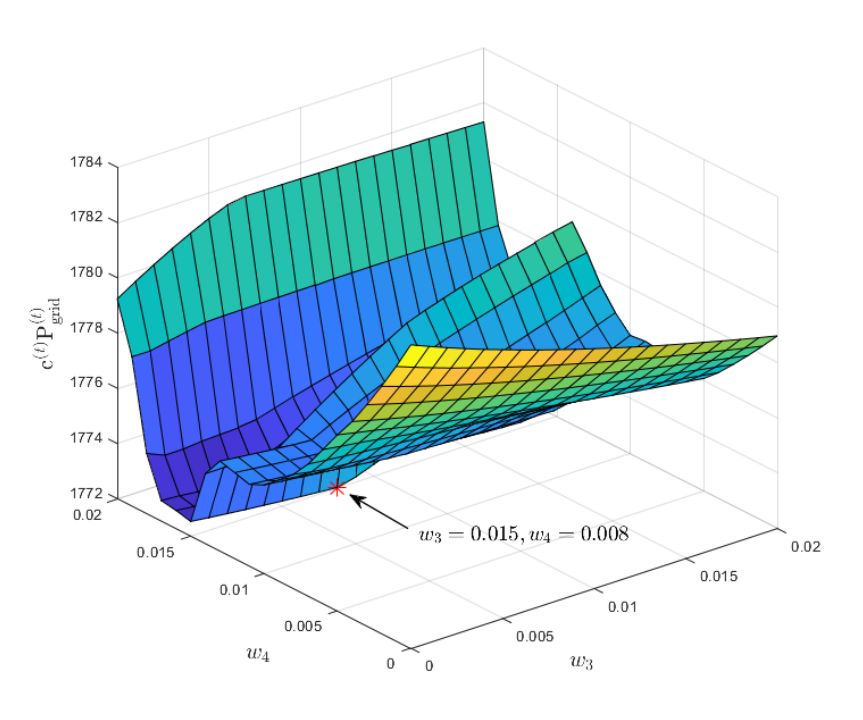
Figure 17. Effect of Weights w 3 and w 4 on the